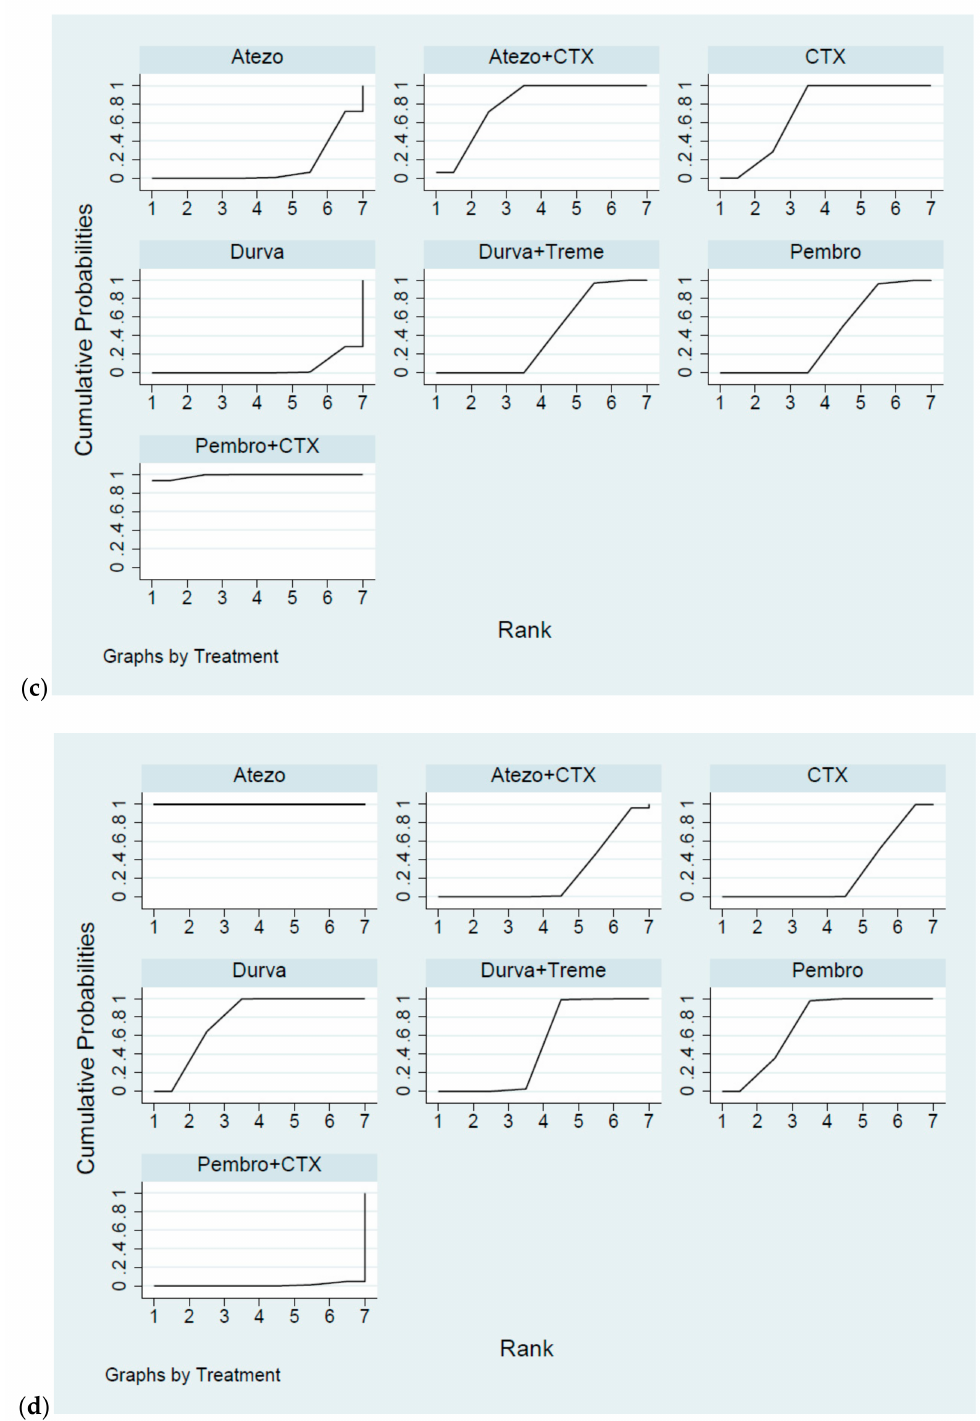
Figure 4. Cumulative ranking probability for different interventions. ( a ) Hazard ratio for overall survival, ( b ) hazard ratio for progression free survival, ( c ) response ratio for overall response rate, ( d ) risk ratio for grade 3–5